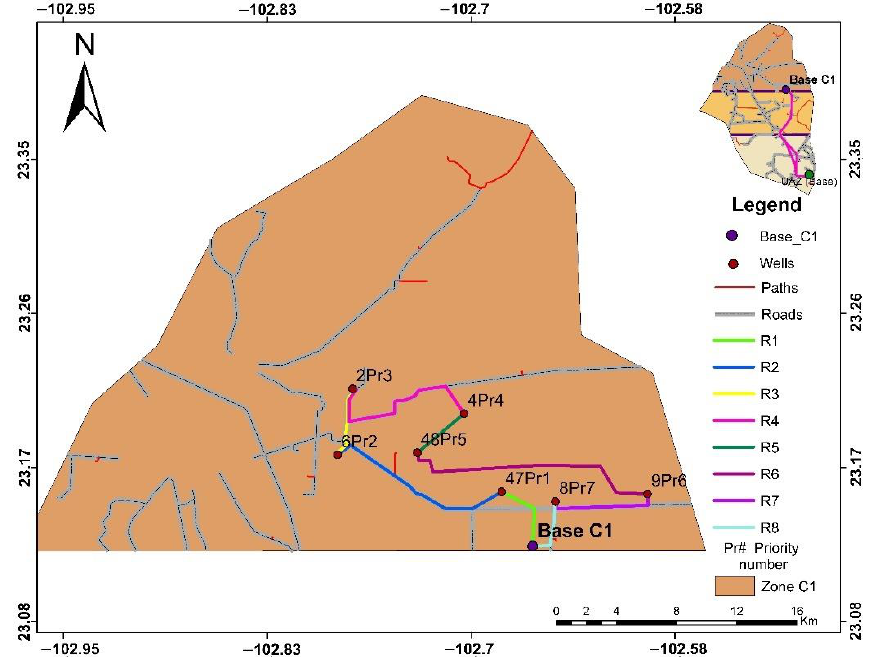
Figure 6. Monitoring wells with their visit priorities for Zone C1, the monitoring route begins and ends at the UAZ (Base).